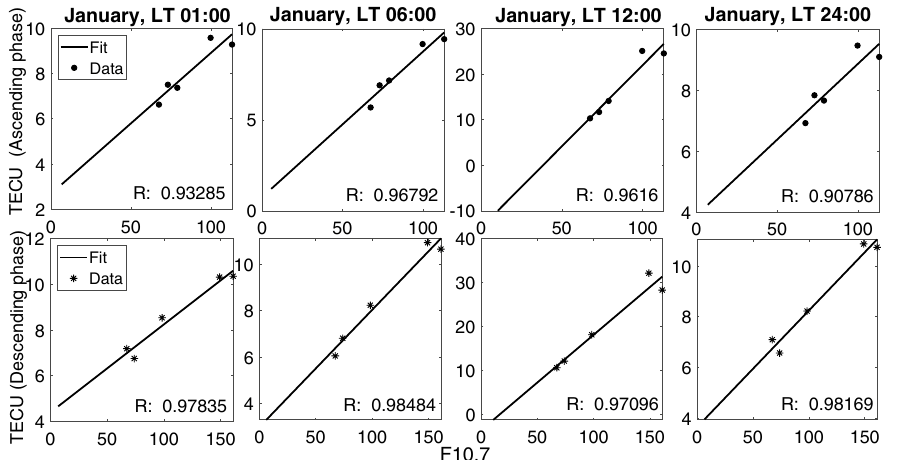
Figure 8. Linear regression fittings and correlation coefficients for the monthly mean values of TEC versus F10.7.